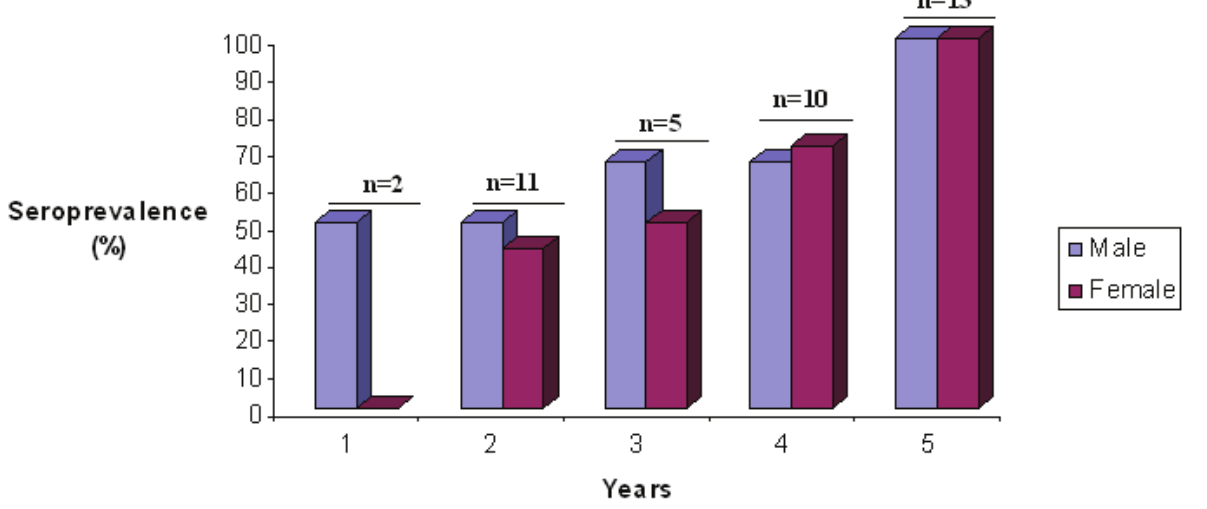
Figure 2. Seroprevalence of simian foamy virus (SFV) antibodies in young female and male semi-free-ranging mandrills at the CIRMF